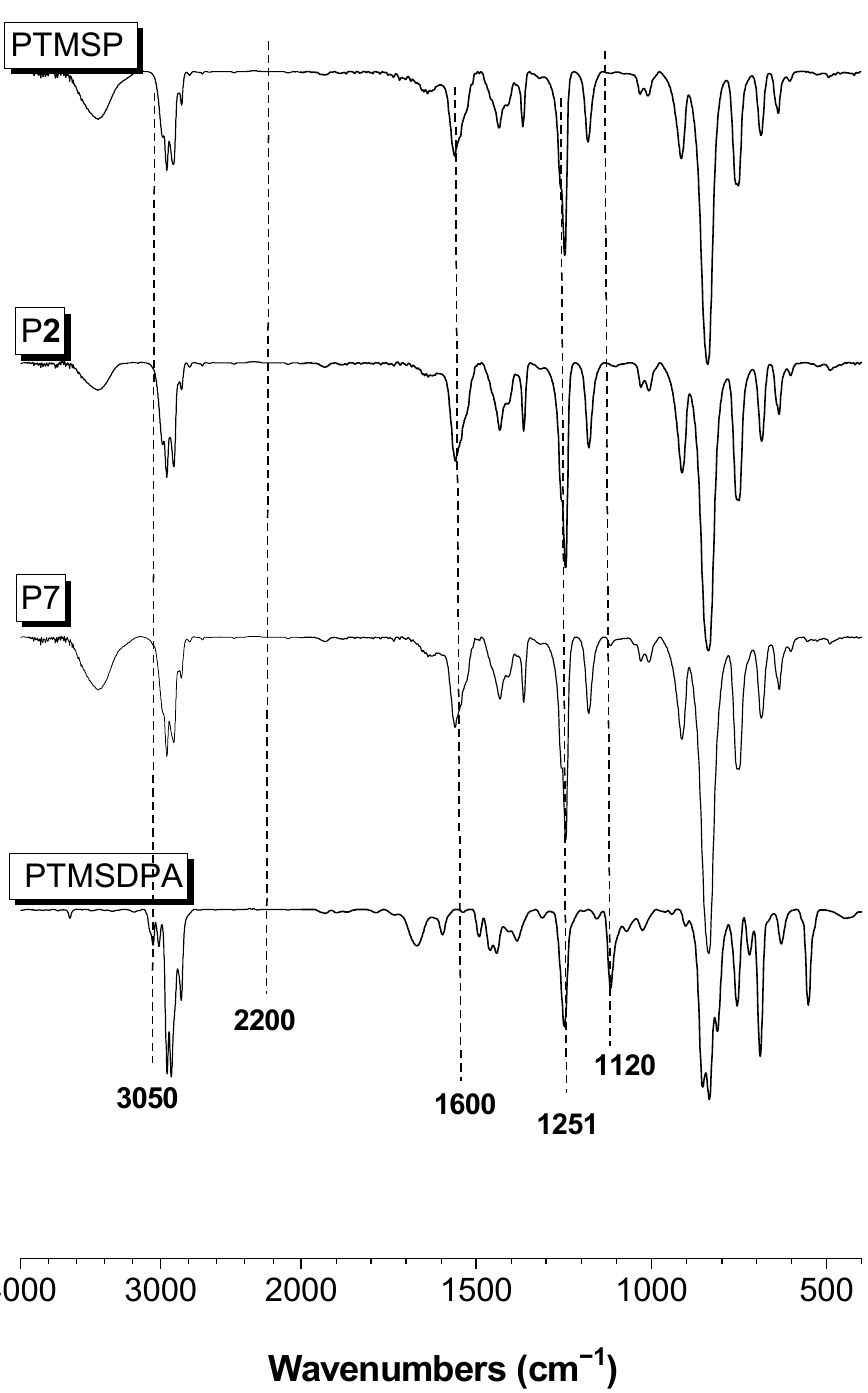
Figure 1. FTIR spectra of PTMSP, P 2 , P 7 , and PTMSDPA in KBr pellets. Further evidence comes from the 1 H NMR spectra (Figure 2) of PTMSP, P 7 , and PTMSDPA. The signal in the low-field part of the spectrum was amplified for analysis. The resonant peak around 7.5 ppm, which was assigned to the protons of the benzene ring, existed in P 7 . The monomer showed a sharp resonance signal around 0.1 ppm, which was assigned to the protons of methyl and transformed into a dull band. The above results suggest that copolymerization of phenyl disubstituted acetylene and alkyl-silyl disubstituted acetylene has been successfully